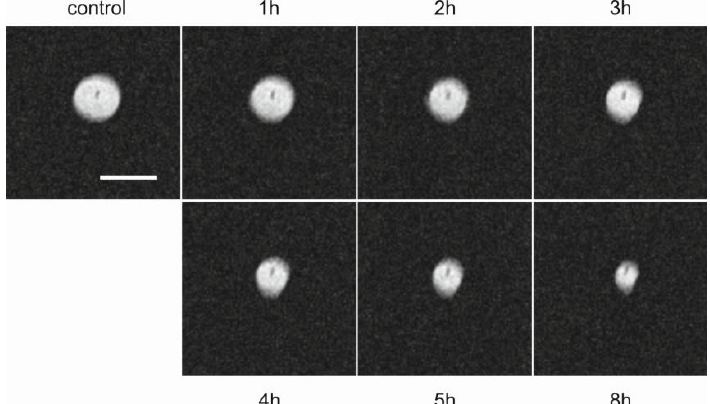
Figure 4. Cross-sectional MR images of a cylindrical sample of courgette during osmotic dehydration in CuSO 4 solution. Image (control) acquired before the contrast agent was administered and images (1–8 h) acquired at different times of the osmotic process. The dark spots in the centre of the images indicate the location of the sample holder. The scale bar represents 20 mm.